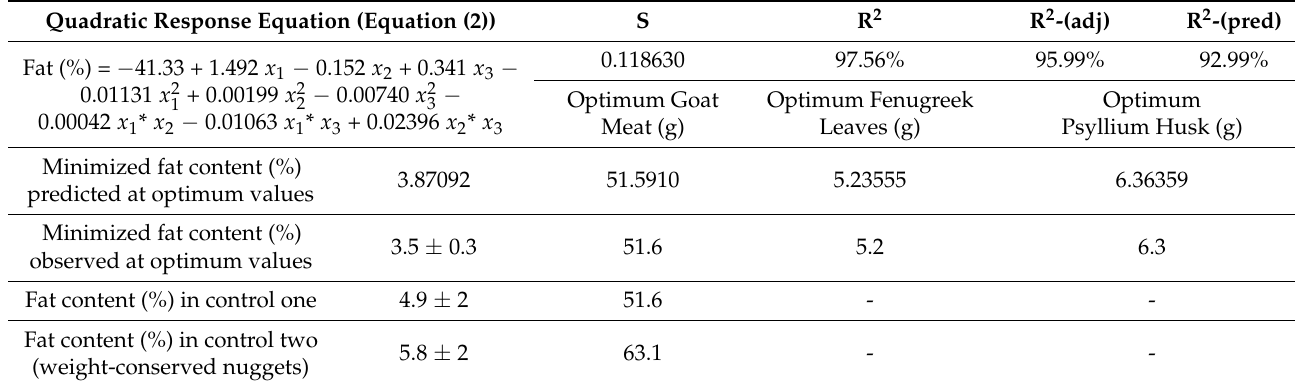
Table 3. Optimum response model.